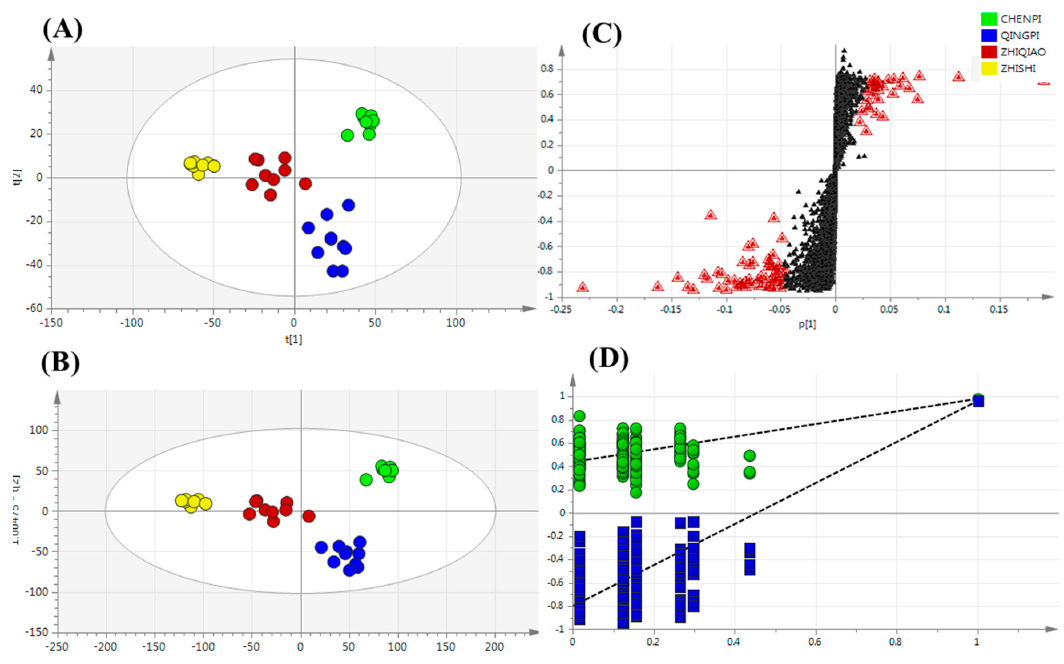
Figure 2. Multivariate statistical analysis of secondary metabolites: ( A ) PCA score plot; ( B ) PLS-DA score plot; ( C ) S-plot of PLS-DA (VIP > 1.0 have been marked); ( D ) cross-validation plot of the PLS-DA model with 100 permutation tests. The most differential compounds are marked with red triangles.